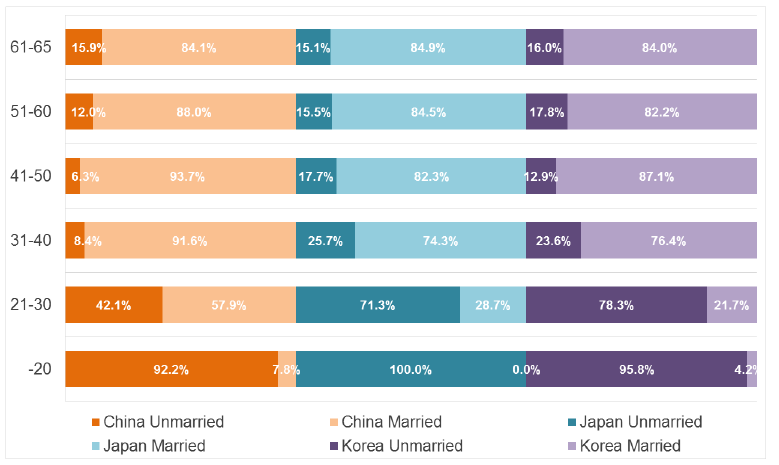
Fig 2. Marriage by Age Groups in China, Japan, and Korea. 10-year age groups in which “ younger than 20 (-20) ” in Japan includes only those who are 20. Numbers in bars indicate percentage of married/unmarried individuals in each